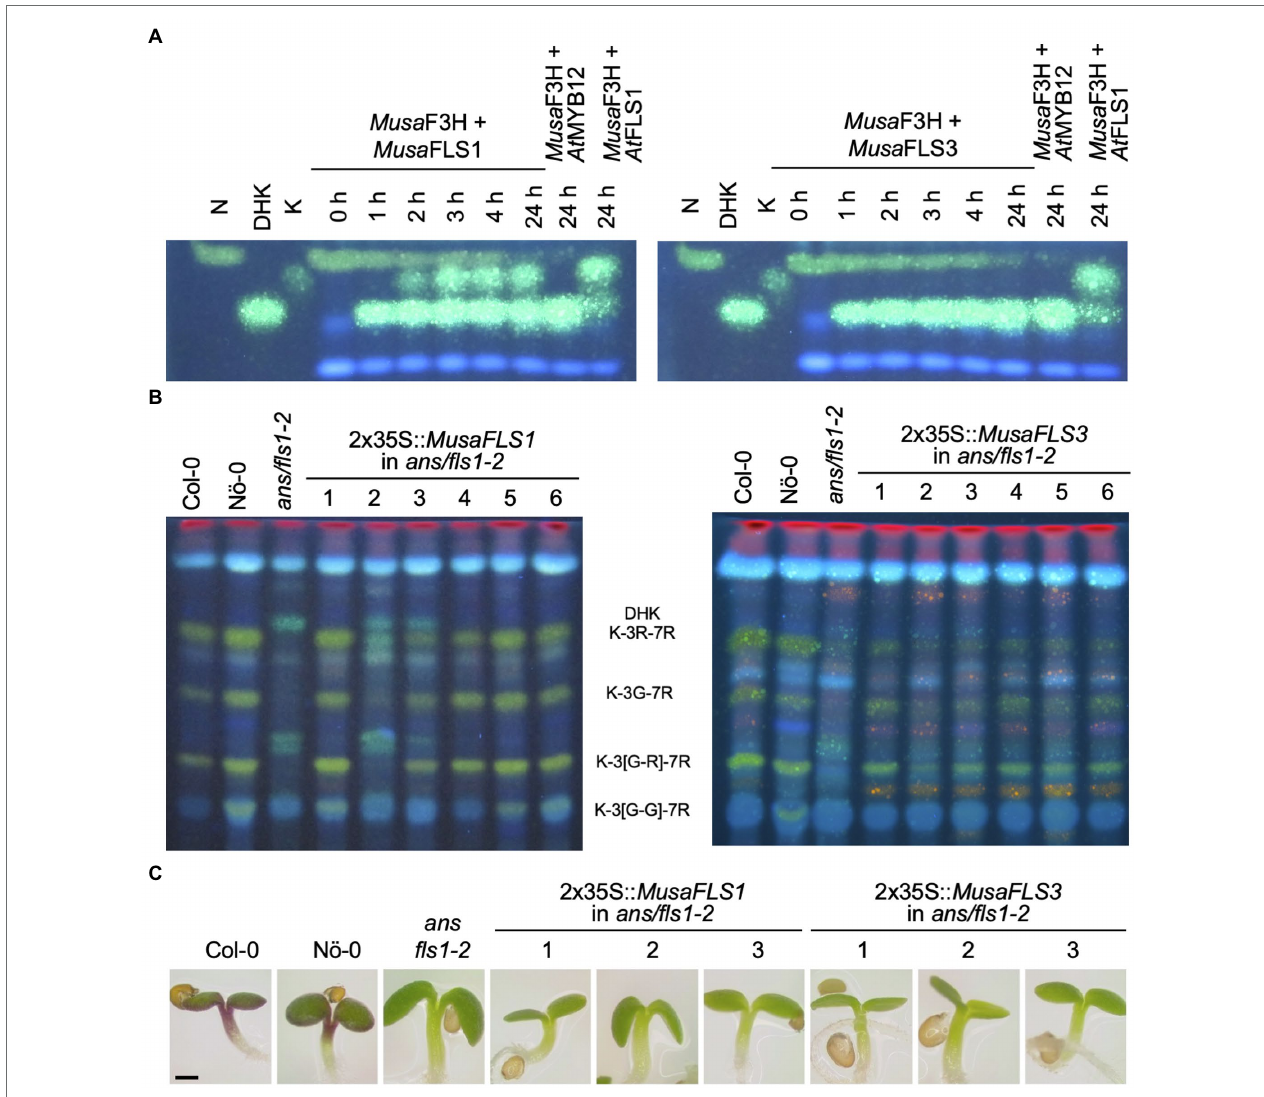
FIGURE 4 | Musa FLS1 and Musa FLS3 are functional FLSs. (A) HPTLC analysis of a FLS bioconversion assays using extracts from E. coli expressing recombinant Musa FLS1 or Musa FLS3. The F3H substrate naringenin (N), the FLS substrate DHK and the product kaempferol (K) were used as standards. At FLS1 served as a positive control and At MYB12 was used as a negative control. (B) Flavonol glycoside accumulation in Musa FLS-complemented ans/fls1-2 seedlings analysed by HPTLC analysis. Col-0, Nö-0 (both wild type) and ans/fls1-2 were used as controls. Bright green spots belong to derivatives of kaempferol, orange spots are derivatives of quercetin and faint blue shows sinapate derivatives. Dark green and yellow spots indicate DHK and DHQ, respectively. G, glucose; K, kaempferol; Q, quercetin; and R, rhamnose. (C) Representative pictures of anthocyanin (red) accumulation in 6-day-old Musa FLS-complemented ans/fls1-2 seedlings growing on 4% sucrose. The scale bar indicates 0.5